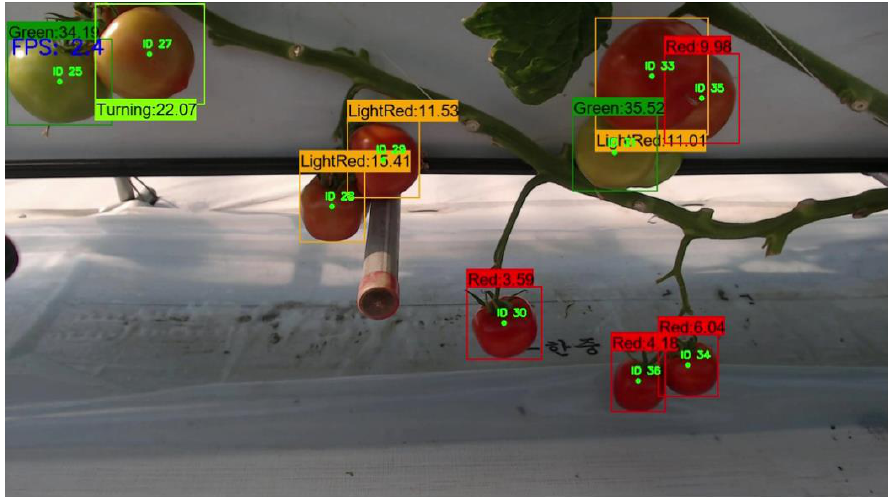
Figure 13. Example of the output images.